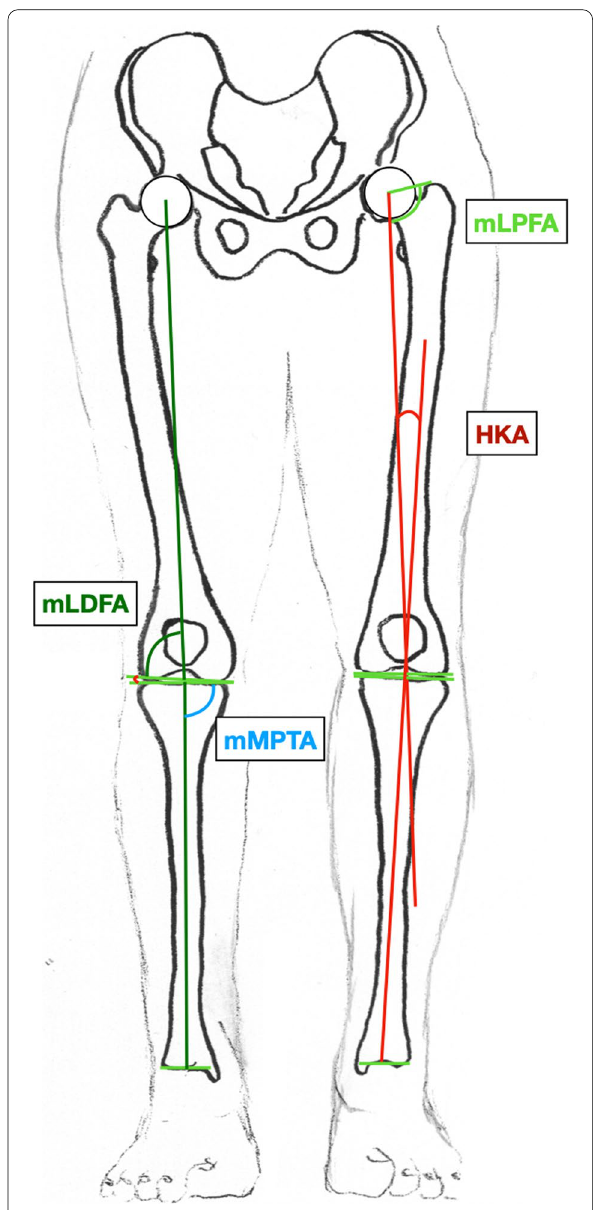
Fig. 3 Illustration of the radiographic parameters measured on a long‑leg standing X‑ray with the knees pointing forward. Measures around the hip and the knee. HKA: Hip Knee Ankle angle, mLDFA: Mechanical lateral distal femoral angle, mLPFA: Mechanical lateral proximal femoral angle, mMPTA: Mechanical medial proximal tibial